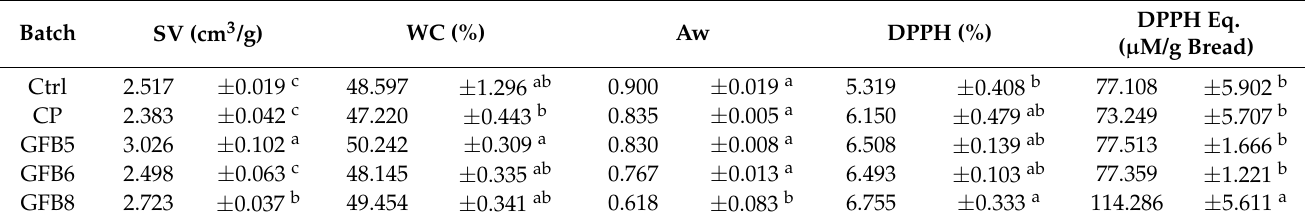
Table 5. Mean values ± standard error of physicochemical parameters performed in bread